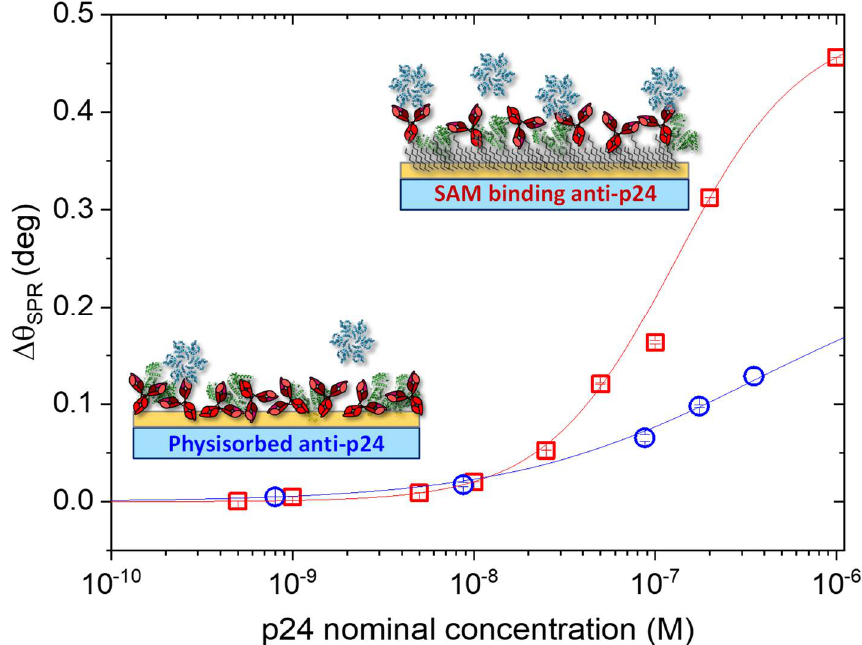
Figure 5. SPR response for the p24 binding on anti-p24 covalently bound on the chemical SAM (red squares) and for the p24 binding on physisorbed anti-p24 (blue circles). The Hill fitting model is shown as red and blue solid lines, respectively.